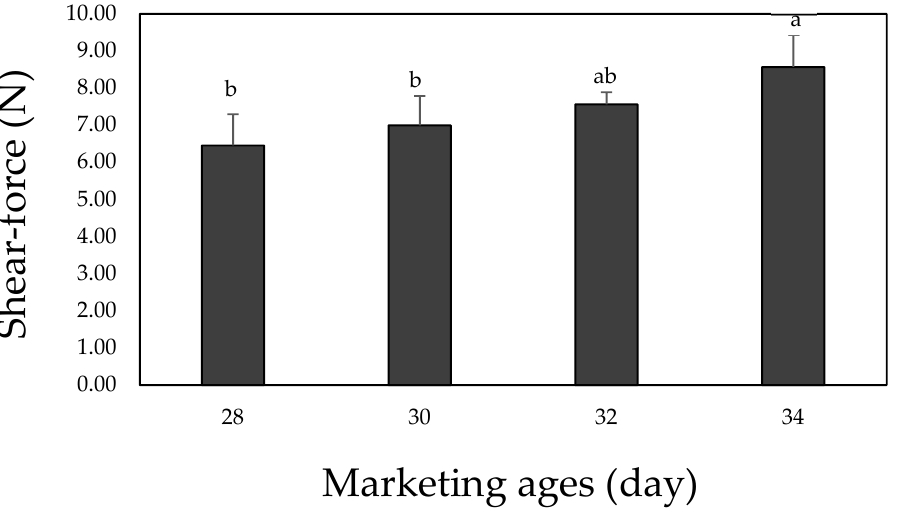
Figure 2. Shear-force of cured chicken breast with various marketing ages. a – b Means on the same bar with different letters are significantly different ( p < 0.05).